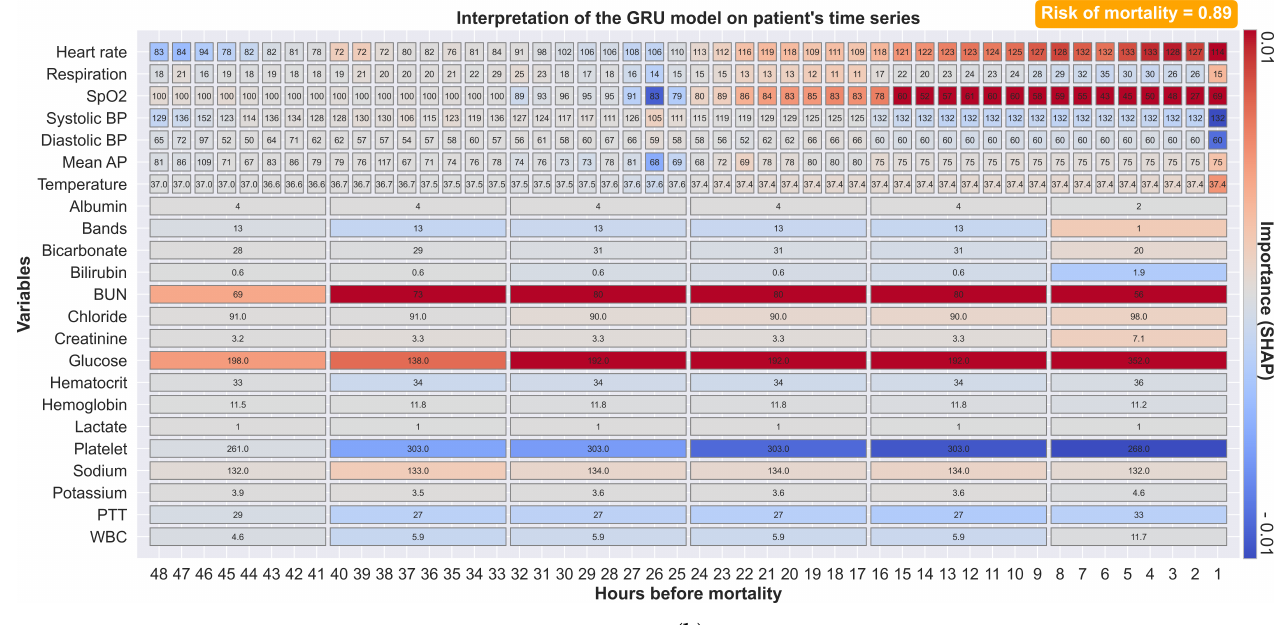
Figure 7. Visualization of SHAP values calculated by our GRU model for 48 h of time-series data preceding mortality. The values of each clinical variable at each time step are presented in each rectangular box, with missing observations filled using carry-forward imputation. The color red indicates positive SHAP values (increased mortality risk), while the color blue indicates negative SHAP values (decreased mortality risk). ( a ) Our approach was able to recognize changes in both vital signs (four hours before mortality for heart rate, SpO 2 , and blood pressure) and laboratory tests (forty hours before mortality for bilirubin, BUN, PTT, and WBC). ( b ) The prediction based on data with a longer period of vital sign alterations. Our model gives more weight to more recent measurements. Our model was able to adapt to specific